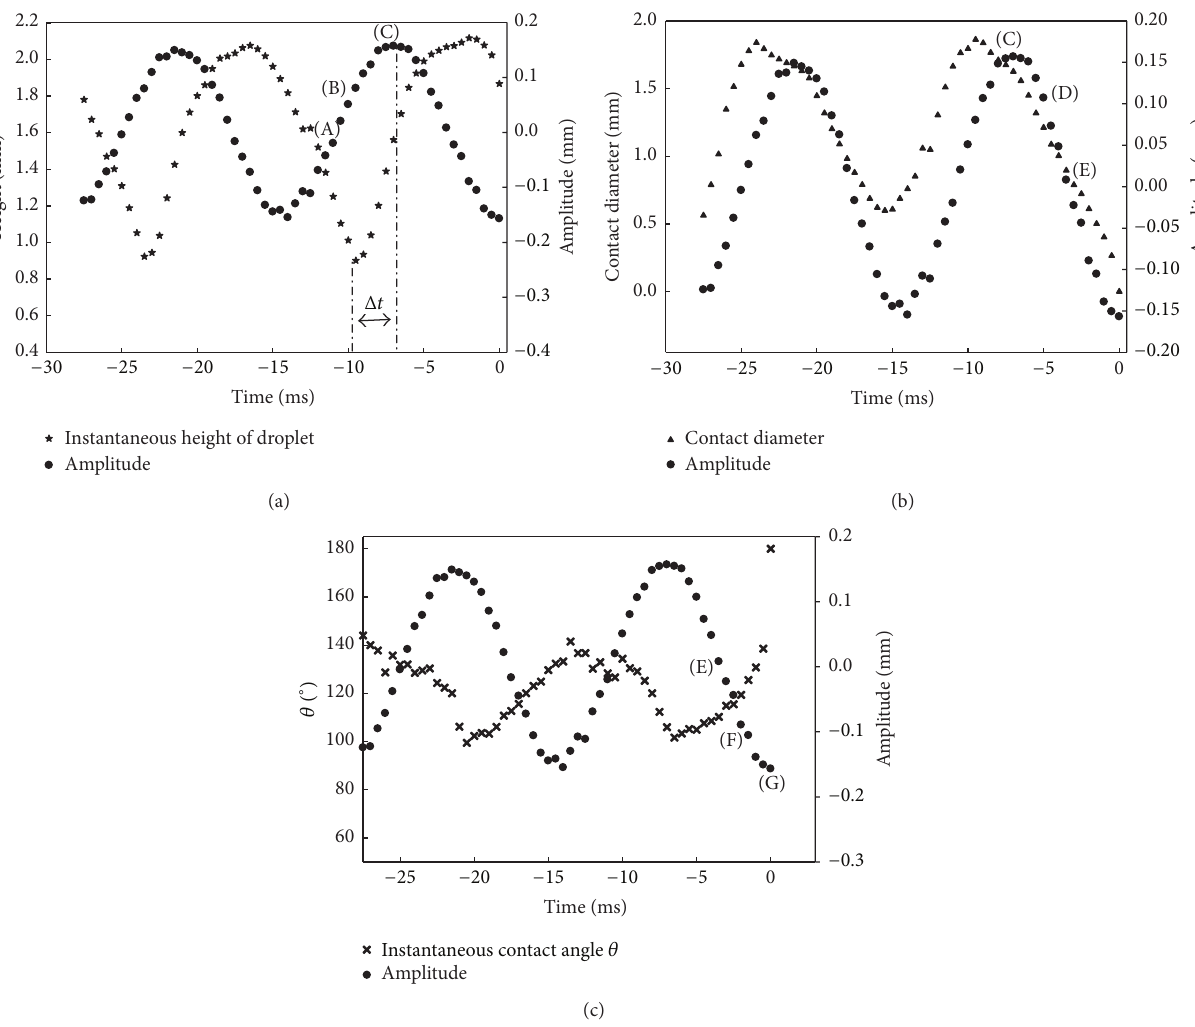
Figure 5: The transient evolution of the droplet and amplitude 𝐴(𝑡) prior to the droplet bouncing-off. (a) The droplet height 𝐻(𝑡) , (b) the droplet contact diameter 𝐷(𝑡) , and (c) the CA 𝜃(𝑡) . The characteristics of the vibrated droplet on the pillared surface can generally be classified into three different categories: compression process (A)–(C), restoring process (C)–(E), and bouncing process